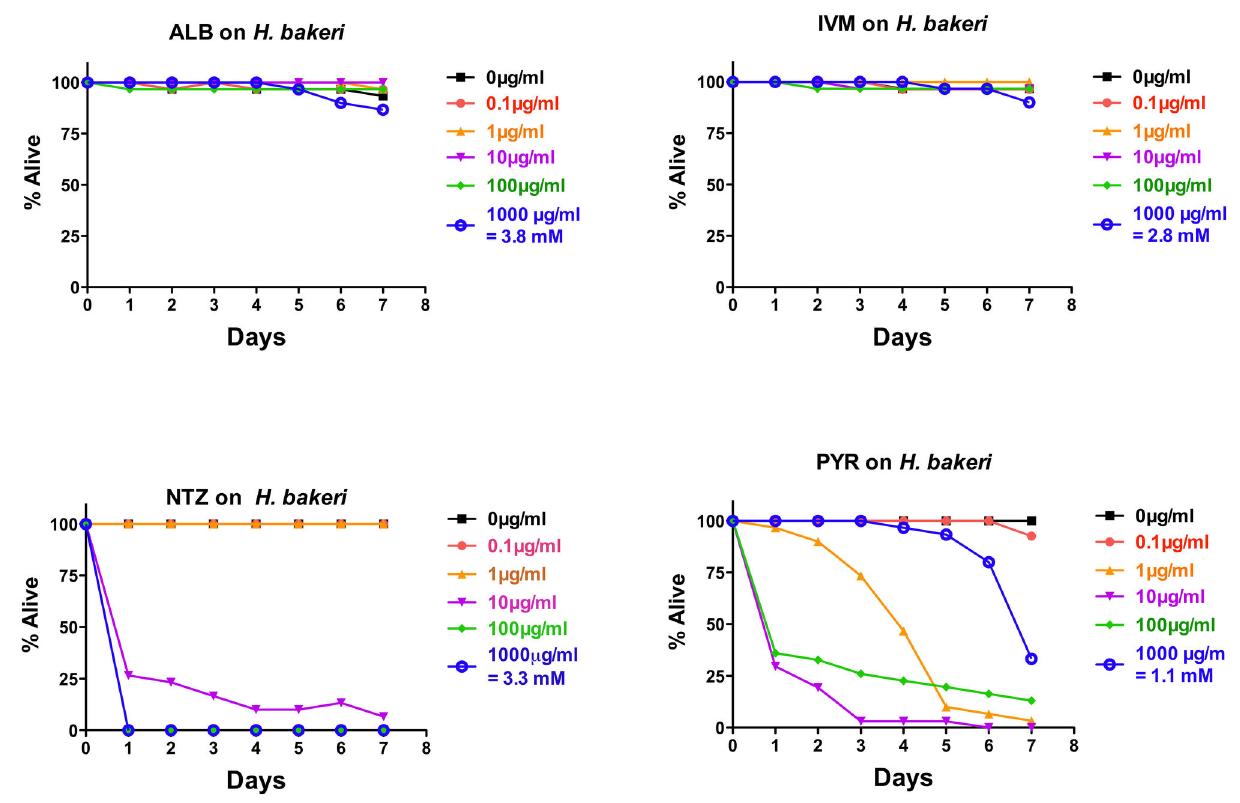
Figure 4. Intoxication of Heligmosomoides bakeri adults in vitro using five doses of albendazole (ALB), ivermectin (IVM), nitazoxanide (NTZ), or pyrantel (PYR). For comparative reference, the molar concentration of each drug at 1000 µg/mL is indicated. Parasites were scored daily for motility. Any motility, including motility after prodding, was counted as “alive.” Lack of motility, including a lack of a response after prodding, was counted as “dead.” Data are the combination of three independent trials with 10